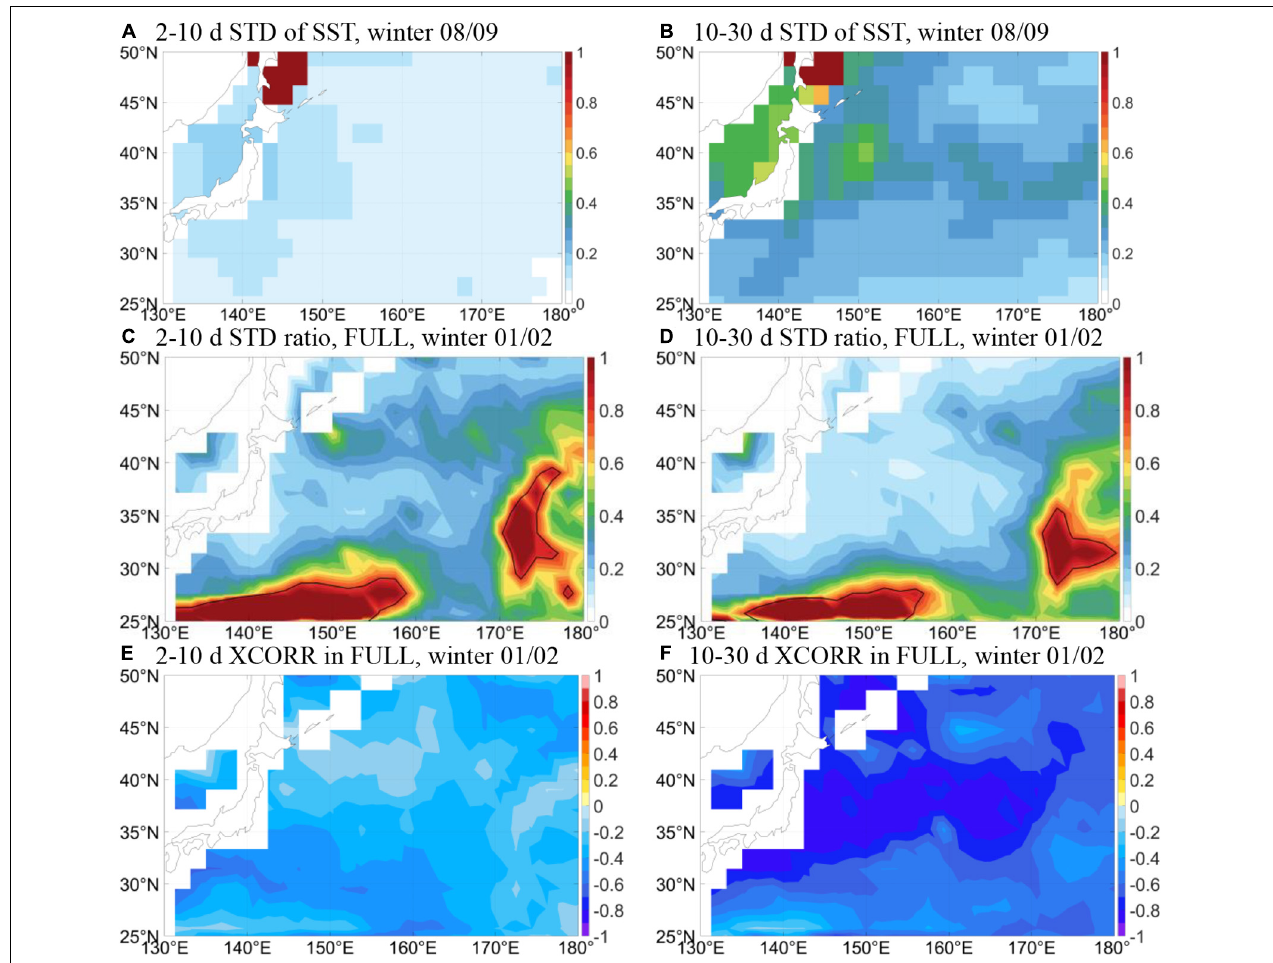
FIGURE 9 | Results based on the 2.5-resolution NCEP/NCAR Reanalysis 1 dataset for winter 2001/02. (A,B) Correspond to Figures 2E,F , (C,D) correspond to Figures 5A,B , and (E,F) correspond to Figures 7E,F